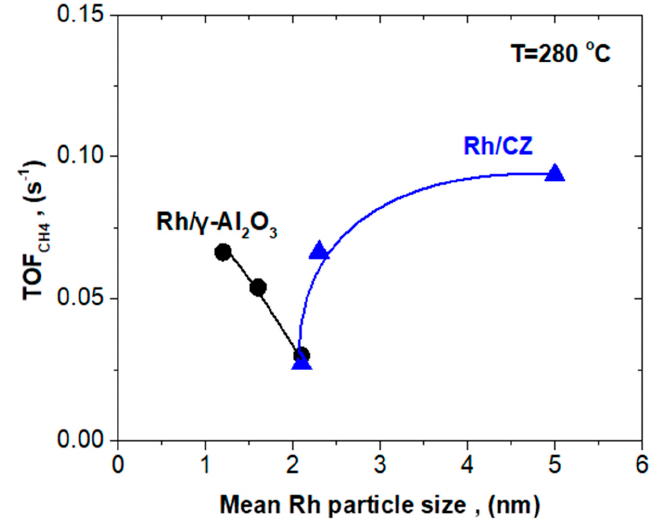
Figure 9. E ff ect of Rh particle size on the turnover frequency of CO 2 formation ( TOF CH4 ) obtained over Rh / γ -Al 2 O 3 and Rh / CZ catalysts at T = 280 ◦ C. Experimental conditions as in Figures 5 and 7 for Rh / γ -Al 2 O 3 and Rh / CZ, respectively, and the reaction to be operated at the di ff erential mode (low